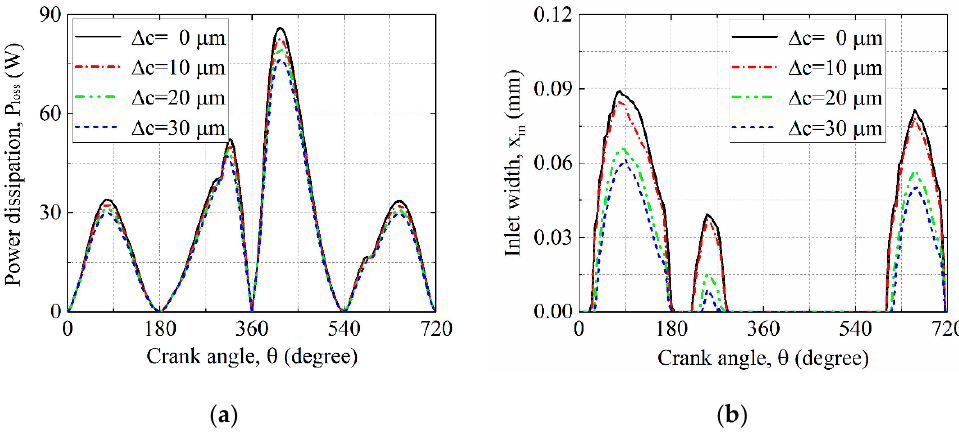
Figure 9. Power dissipation and inlet widths of lubrication zone of the groove textured RLC for different maximum liner deformations: ( a ) Power dissipation; ( b ) inlet width.